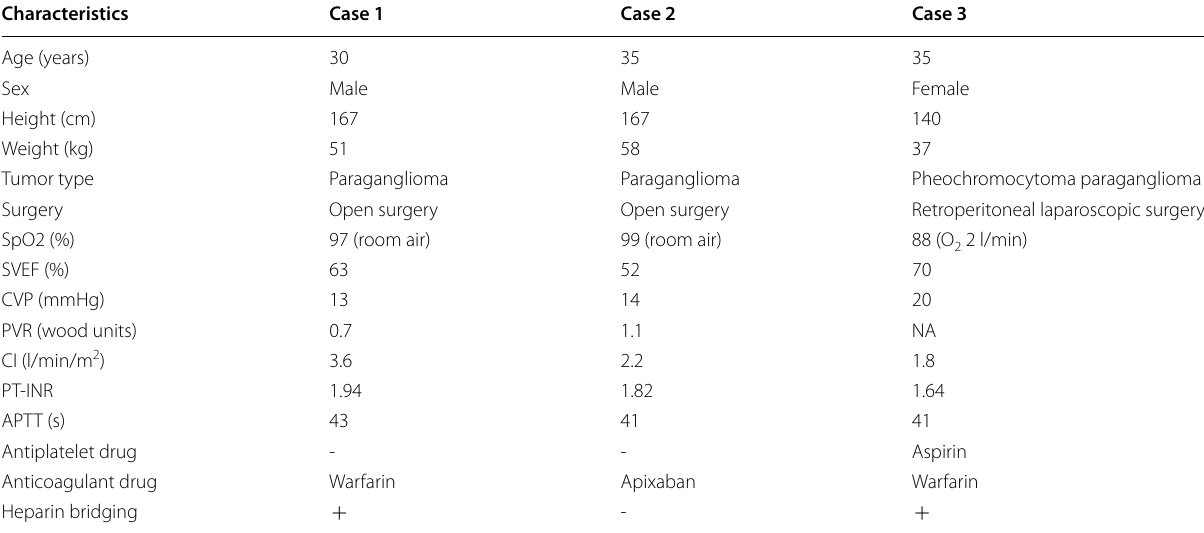
Table 1 Preoperative characteristics of the three cases